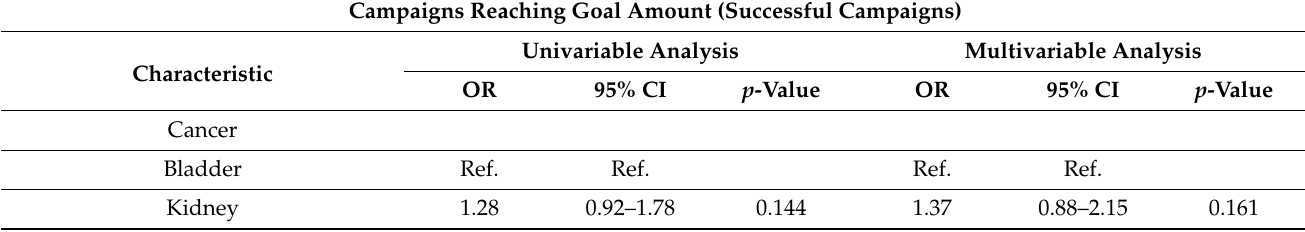
Table 3. Uni- and multivariable logistic regression analyses for campaigns reaching goal amount (successful campaign) and highest fundraising campaigns. Bold numbers were